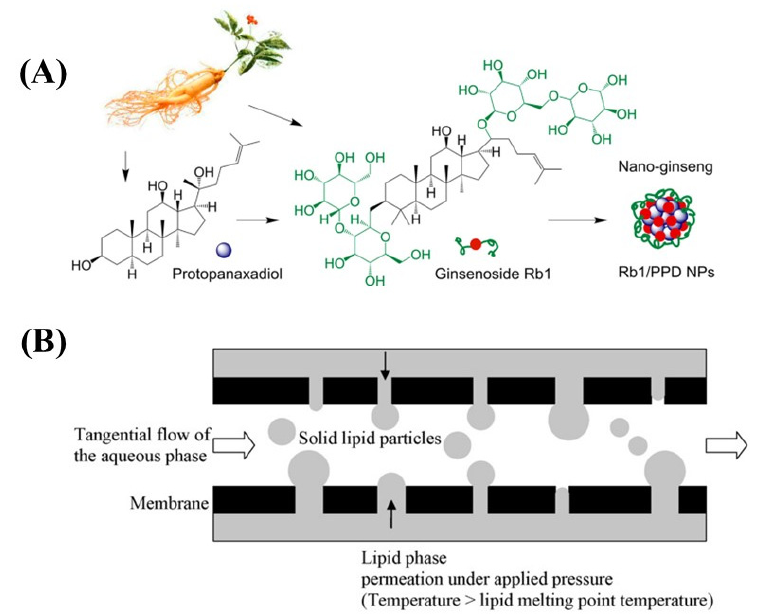
Figure 6. ( A ) Illustration of ginsenoside nanoparticles formed by self-assembly method. ( B ) Schematic drawing of the solid lipid particles by membrane emulsification.